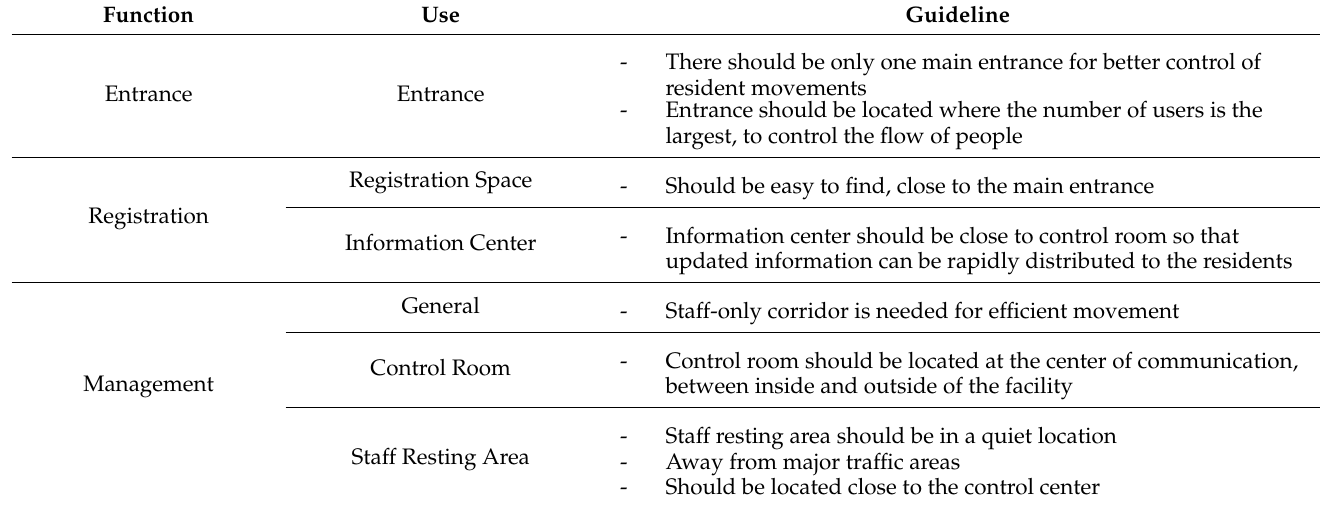
Table 1. Mega-shelter planning guideline elements that influence spatial